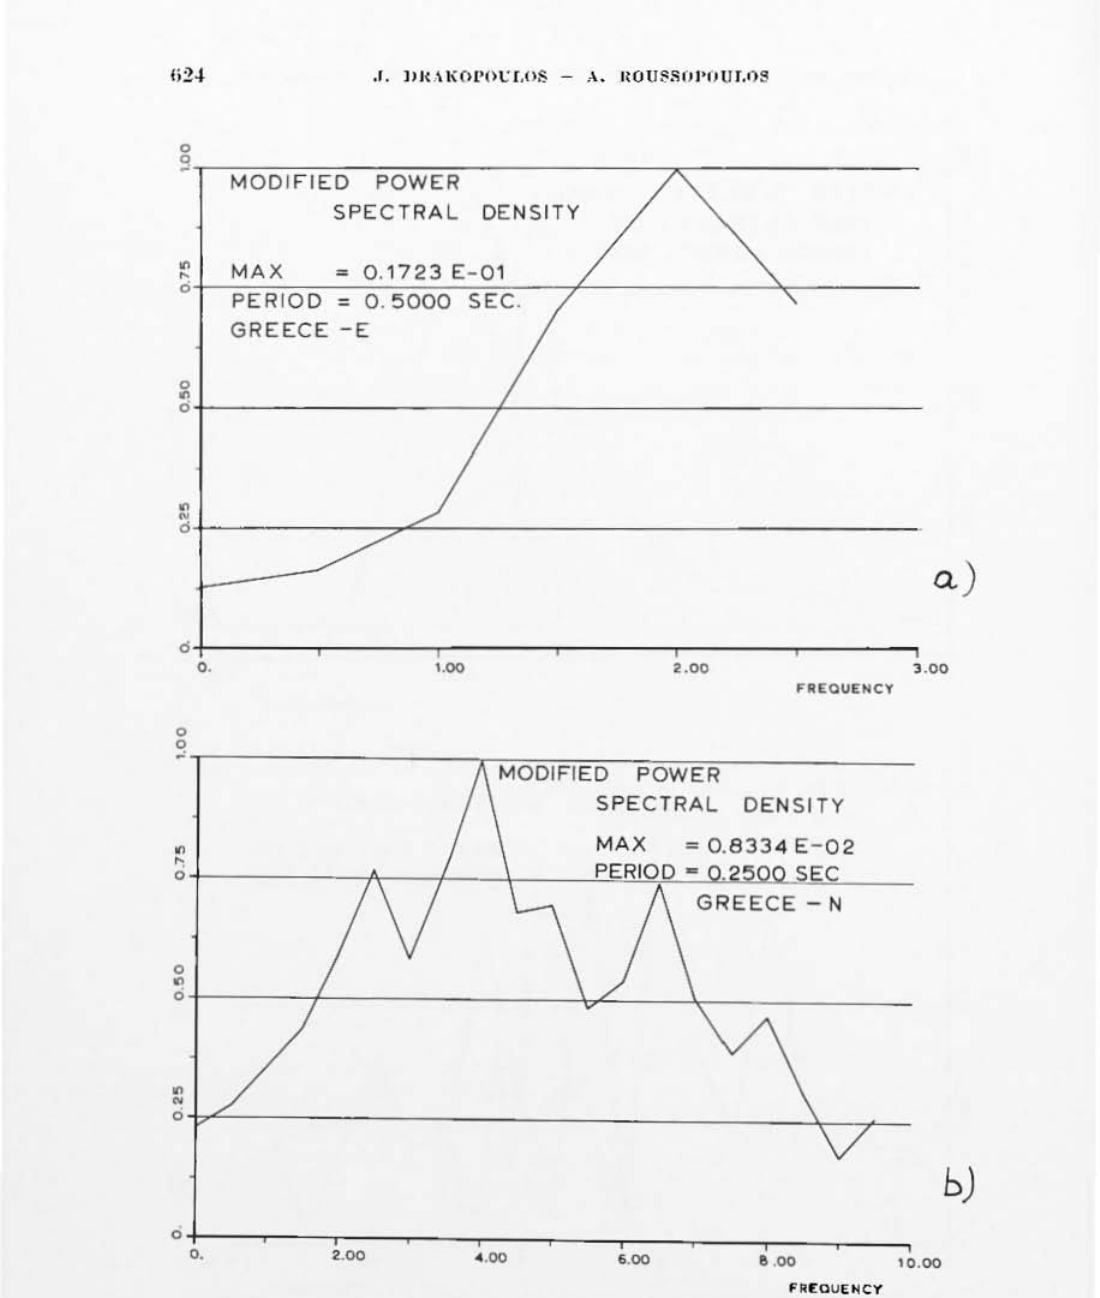
Fig:. 8 - "'flIlific.1 powc,' 61)cd ,ral Ilcm~iry of the lIIaill shock fM the E W